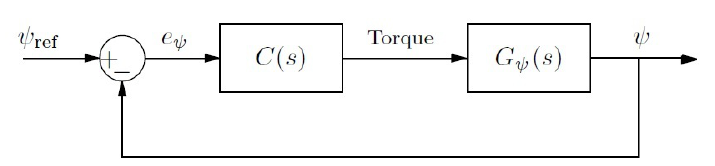
Figure 7. Block diagram of the closed loop system for the yaw